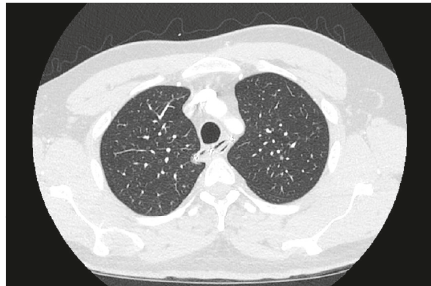
Figure 2: CT of the chest abdomen and pelvis showing metallic foreign body lodged in the upper esophagus without evidence of perforation.